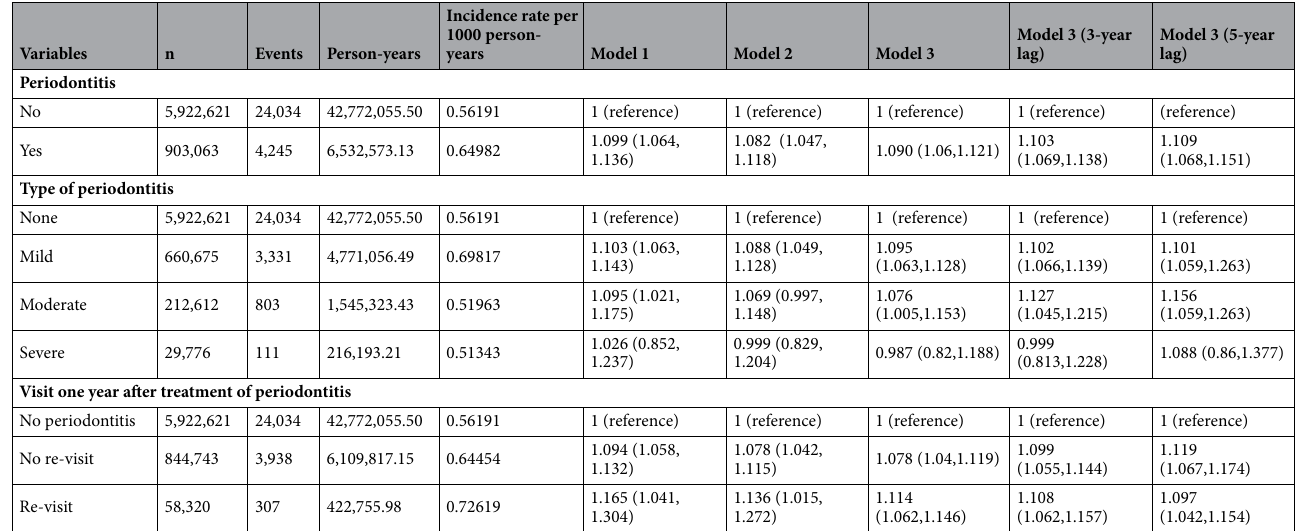
Table 2. Longitudinal association between the severity of periodontitis and incidence of Parkinson’s disease. Model 1 was adjusted for age and sex. Model 2 was adjusted for the values in Model 1 plus smoking status, drinking habits, exercise habits, income level, body mass index, diabetes mellitus, hypertension, and dyslipidemia. Model 3 was adjusted for the values in Model 2 plus stroke and